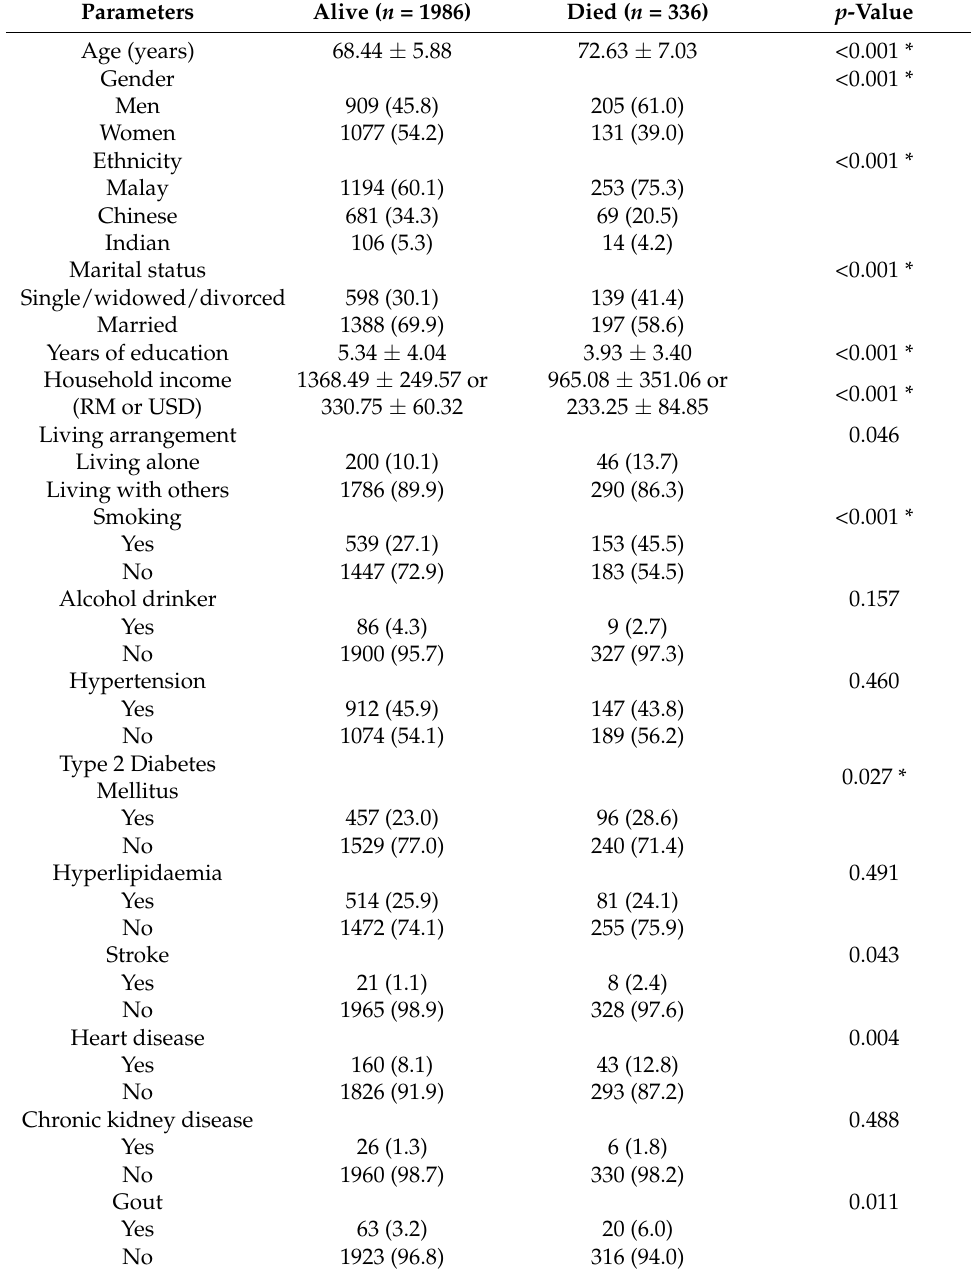
Table 2. The baseline characteristic of p respondents who were alive or died after five years [presented as mean ± standard deviation (sd) or n